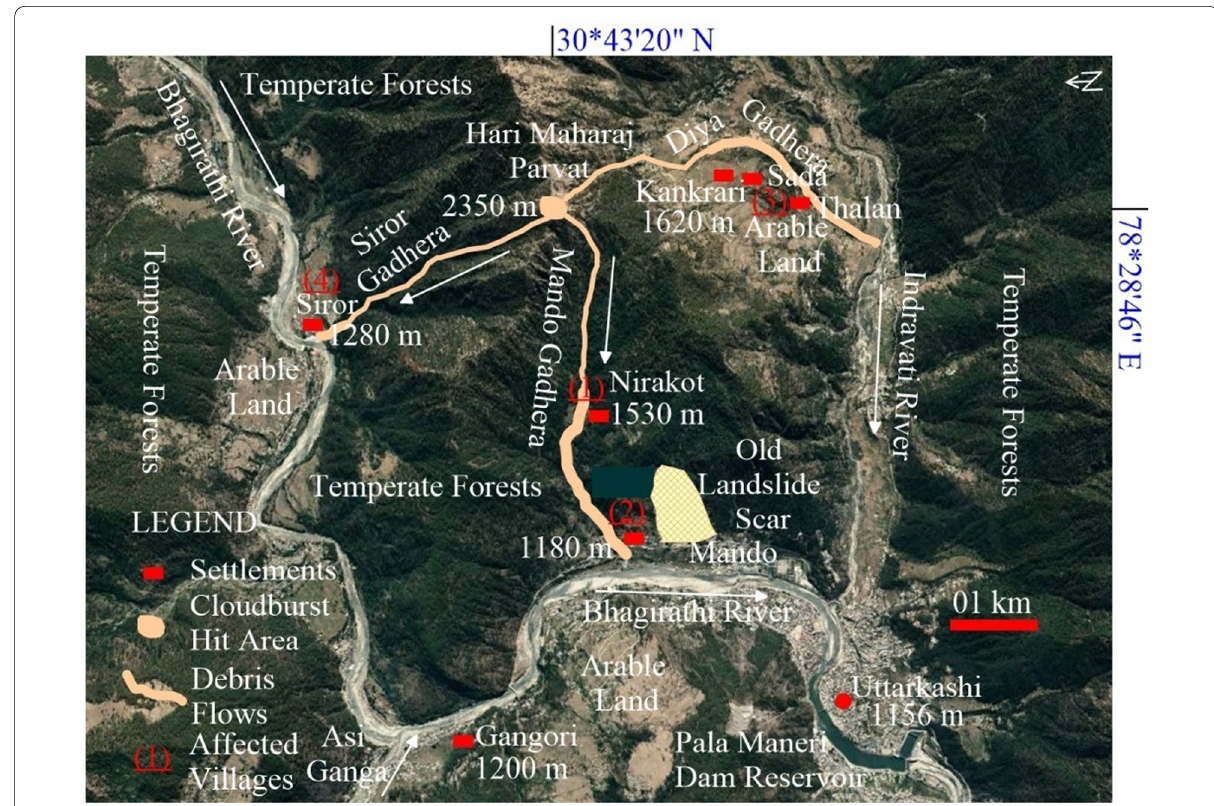
Fig. 2 Location map of cloudburst source and hit areas and their